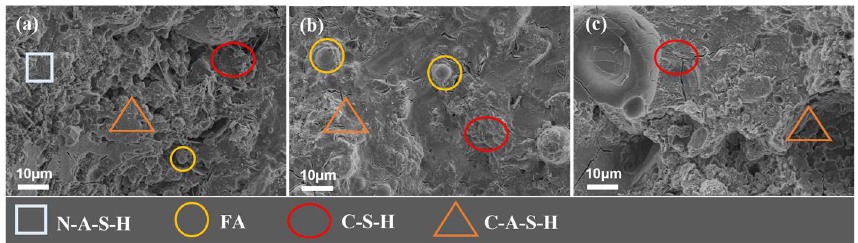
Figure 23. SEM morphology of geopolymer slurry with different NaOH content (28d, slag: 40%, Na 2 SiO 3 : 5%). ( a ) NaOH content: 2%; ( b ) NaOH content: 3.5%; ( c ) NaOH content: 5%.